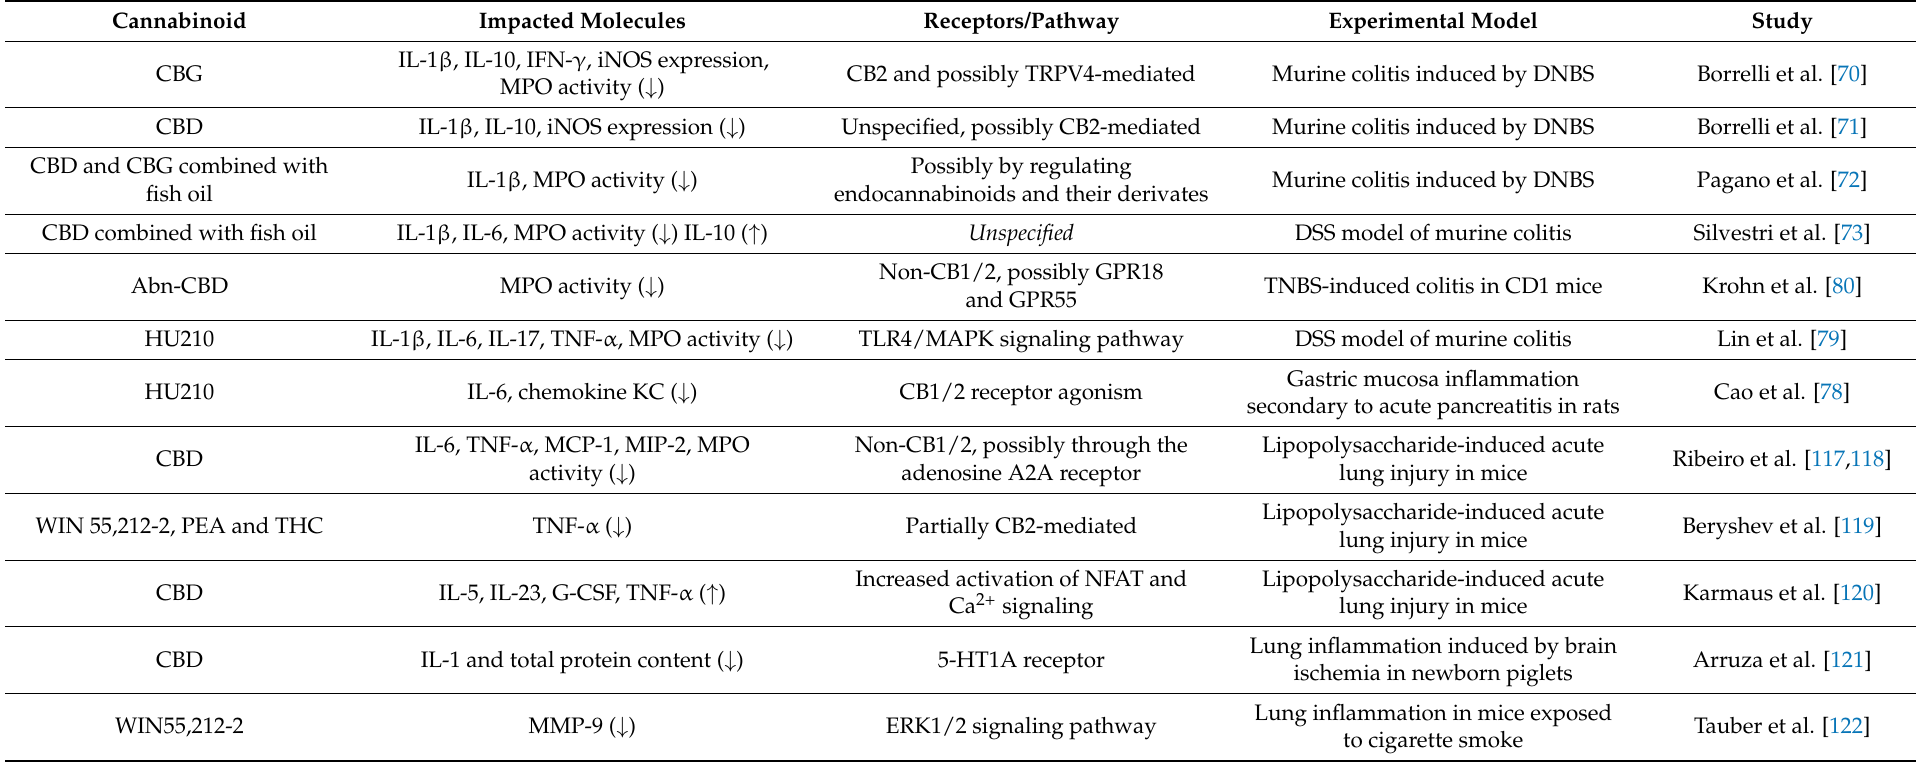
Table 2. The roles of cannabinoids in inflammatory conditions of the gut-lung-skin barrier evidenced in in vivo